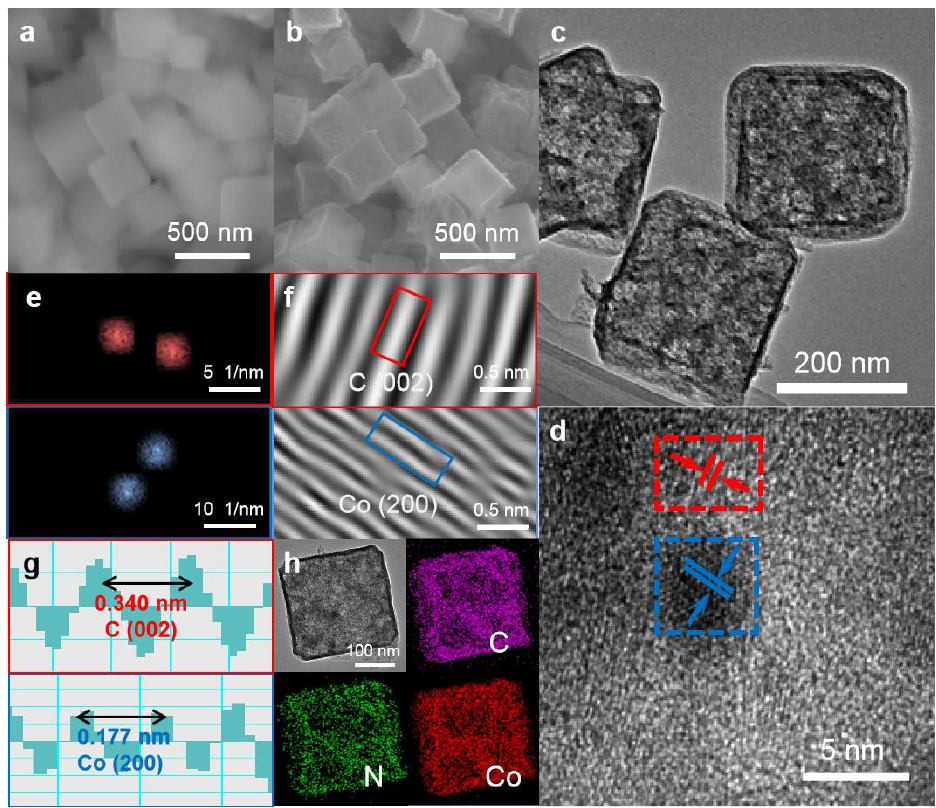
Figure 1. SEM images of ( a ) ZIF-67 and ( b ) Co-NC600; ( c ) TEM image and ( d ) HRTEM image of Co-NC600; (e) applied masked points of FFT patterns; ( f ) inverse FFT lattice images of ( e ); ( g ) the lattice spacing contour of Co-NC600; ( h ) elemental mapping of Co-NC600.